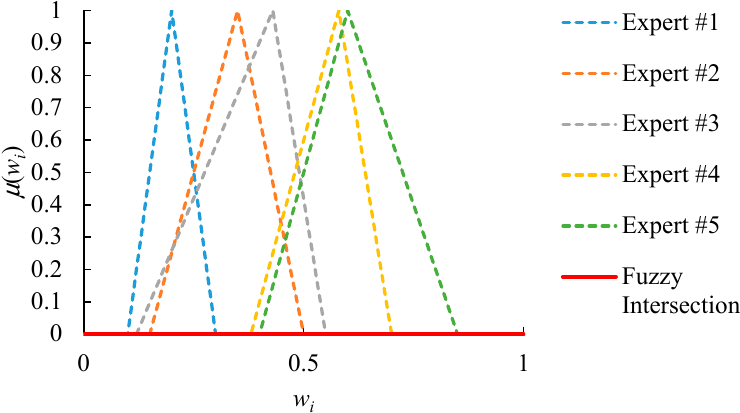
Figure 4. The fuzzy intersection result of five experts’ judgments without a consensus.